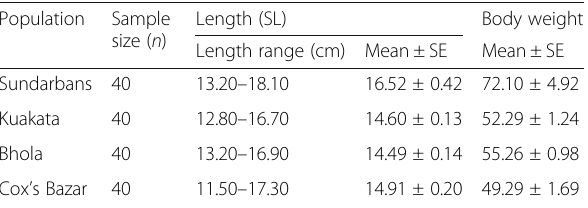
Table 3 Descriptive data of sardine A. clupeoides samples from the Bay of Bengal coast, Bangladesh Population Sample size ( n )